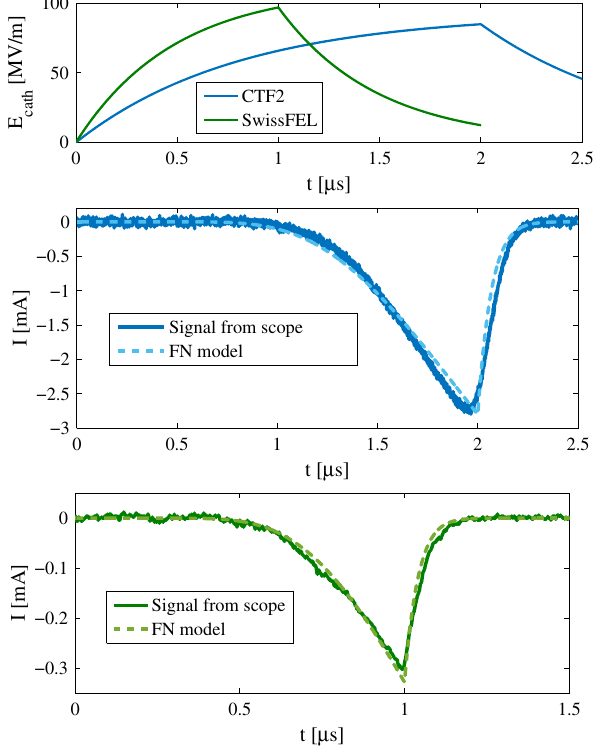
FIG. 11. Rf field amplitude of the SwissFEL and CTF2 gun (top plot), comparison of the FC measured trace and those obtained from the Fowler-Nordheim fit (dashed line) corresponding to the CTF2 (middle plot) and the SwissFEL (bottom plot) gun.